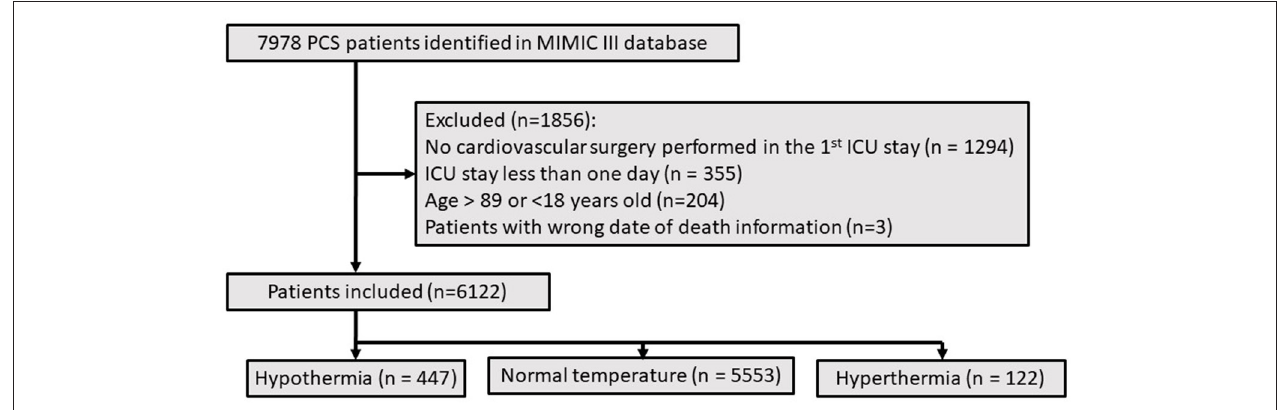
FIGURE 1 | Flowchart of study cohort